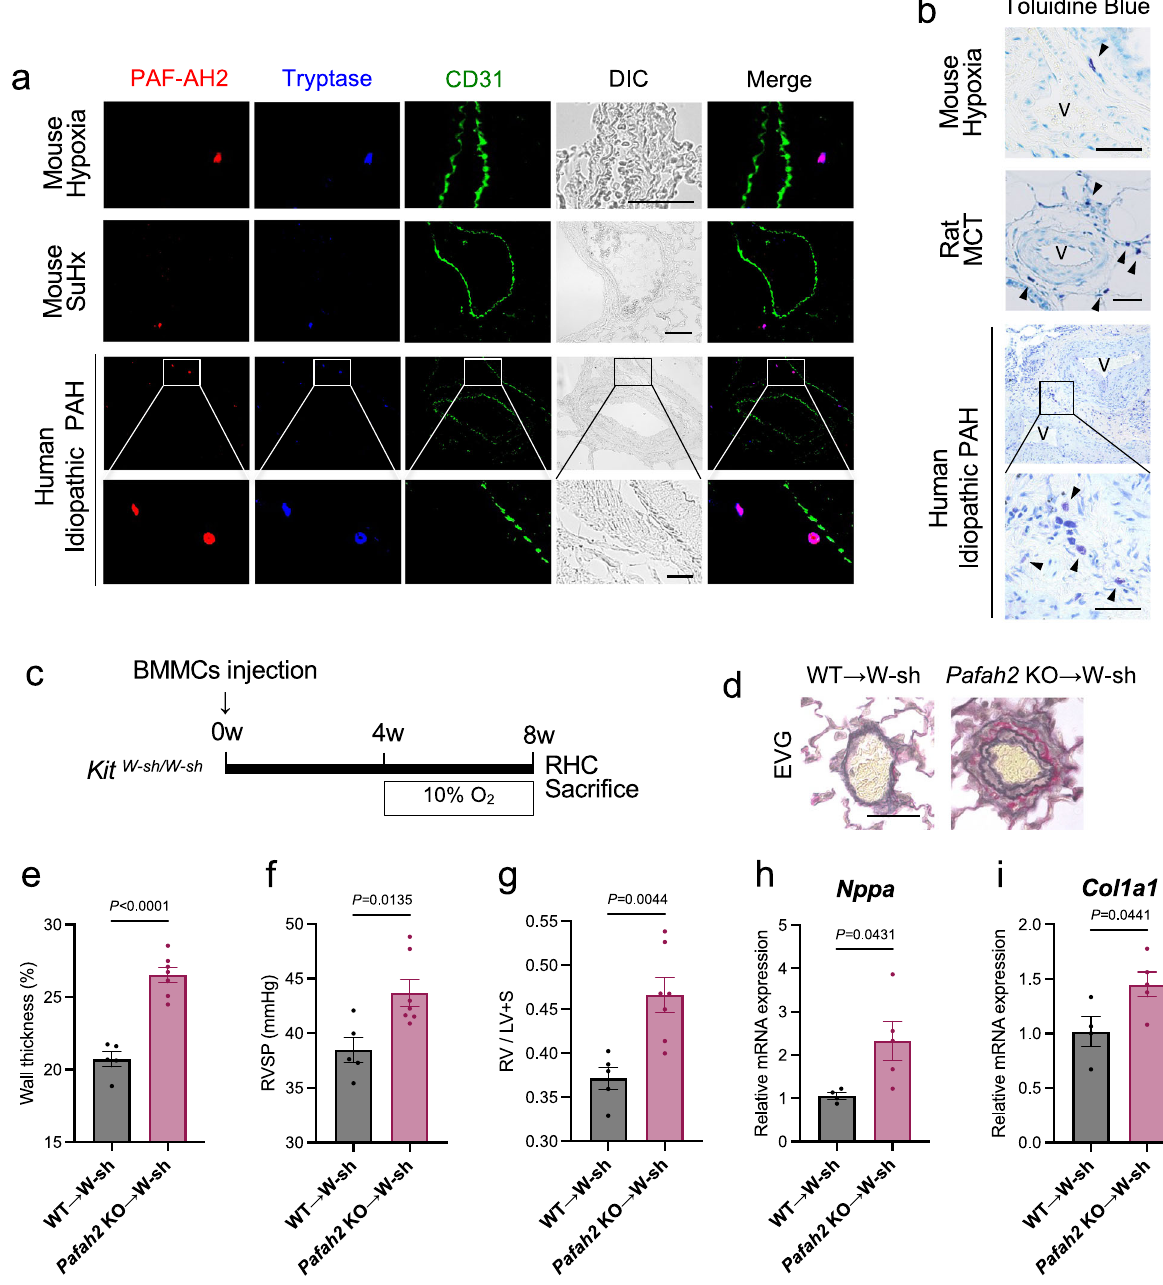
Fig. 3 Mast cells are responsible for the phenotype of Pafah2 KO mice. a Representative image of immunostaining of PAF-AH2, Tryptase and CD31 in lung from PH mice or PAH patient. SuHx; Sugen/hypoxia. Scale bar, 50 μ m. b Representative image of toluidine blue staining of lung sections in PH mice, PH rat, or PAH patient. Arrows indicate Toluidine blue-positive mast cells. V vascular lumen, MCT Monocrotaline. Scale bar, 50 μ m. c Schematic diagram of Kit W-sh/W-sh mice reconstituted with BMMCs subjected to PH. RHC right heart catheterization. d Representative image of EVG staining of pulmonary arterioles in Kit W-sh/W-sh mice reconstituted with WT BMMCs (WT → W-sh) or Pafah2 KO BMMCs ( Pafah2 KO → W-sh) after 4 weeks of hypoxic exposure. Scale bar, 50 μ m. e – g The evaluation of PH severity of BMMC-reconstituted Kit W-sh/W-sh mice exposed to hypoxia ( n = 5,7). Wall thickness of pulmonary arterioles ( e ), RVSP ( f ), weight ratio of RV to LV + septum ( g ). Experiments were repeated twice and the data were pooled ( f , g ). Relative mRNA levels of Nppa in RV ( h ) and Col1a1 in lungs ( i ) of BMMC-reconstituted Kit W-sh/W-sh mice exposed to hypoxia. ( n = 4,5). Expression levels were normalized to those of 18S ribosomal RNA and then to those in the RV or lung of WT → W-sh mice. Data are mean ± SEM. P values were determined by 2-tailed Student ’ s T speci fi c to ω -3 epoxides. Although their points of action have not The substrate selectivity of plasma-type PAF-AH and PAF- been de fi nitively identi fi ed in detail thus far, the TGF- β signaling AH2 is similar 16 . In addition to PAF, both PAF-AHs can hydrolyze phospholipids with short and/or oxidized sn-2 fatty pathway may be involved in the underlying mechanism as 19, 20- acyl chain, but hardly hydrolyze phospholipids with two long EpDPE, an ω -3 epoxide, signi fi cantly suppressed the phosphorylation fatty acyl chains. Recently it has been becoming clear that both of Smad2, which is stimulated by TGF- β , in lung fi broblasts.